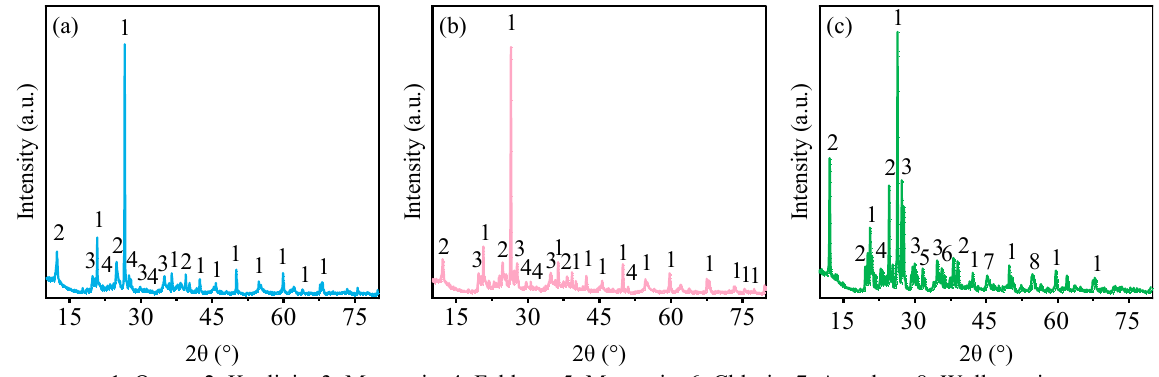
Figure 4. X-ray diffraction pattern of the roof samples: ( a ) MS14; ( b ) MS15; ( c ) MCS16. 5.3% 8.9%